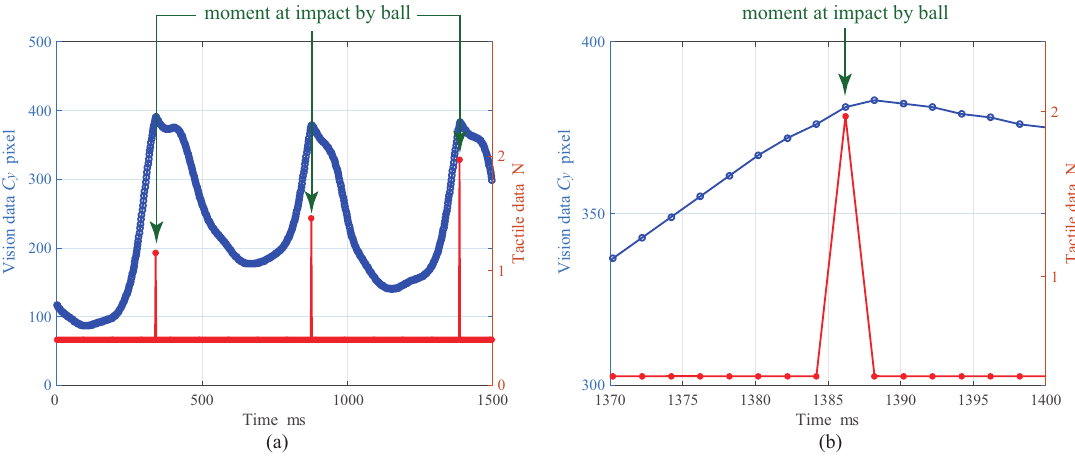
Figure 6. Result of Experiment 2: ( a ) shows tracking data and force data, and ( b ) shows enlarged